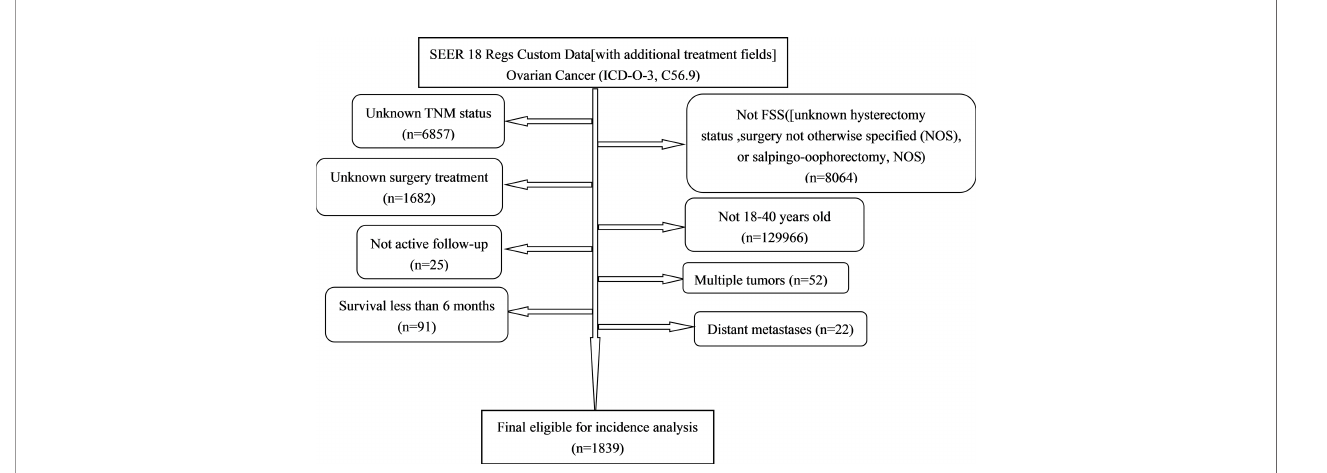
FIGURE 1 | Flowchart of patient selection from the